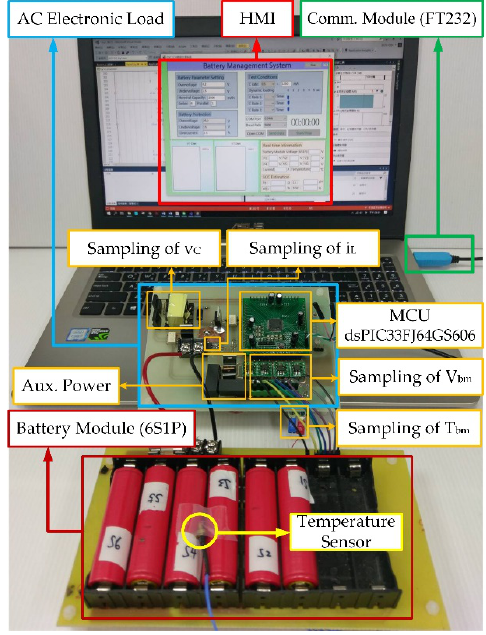
Figure 17. Photographs of the experiment setup.